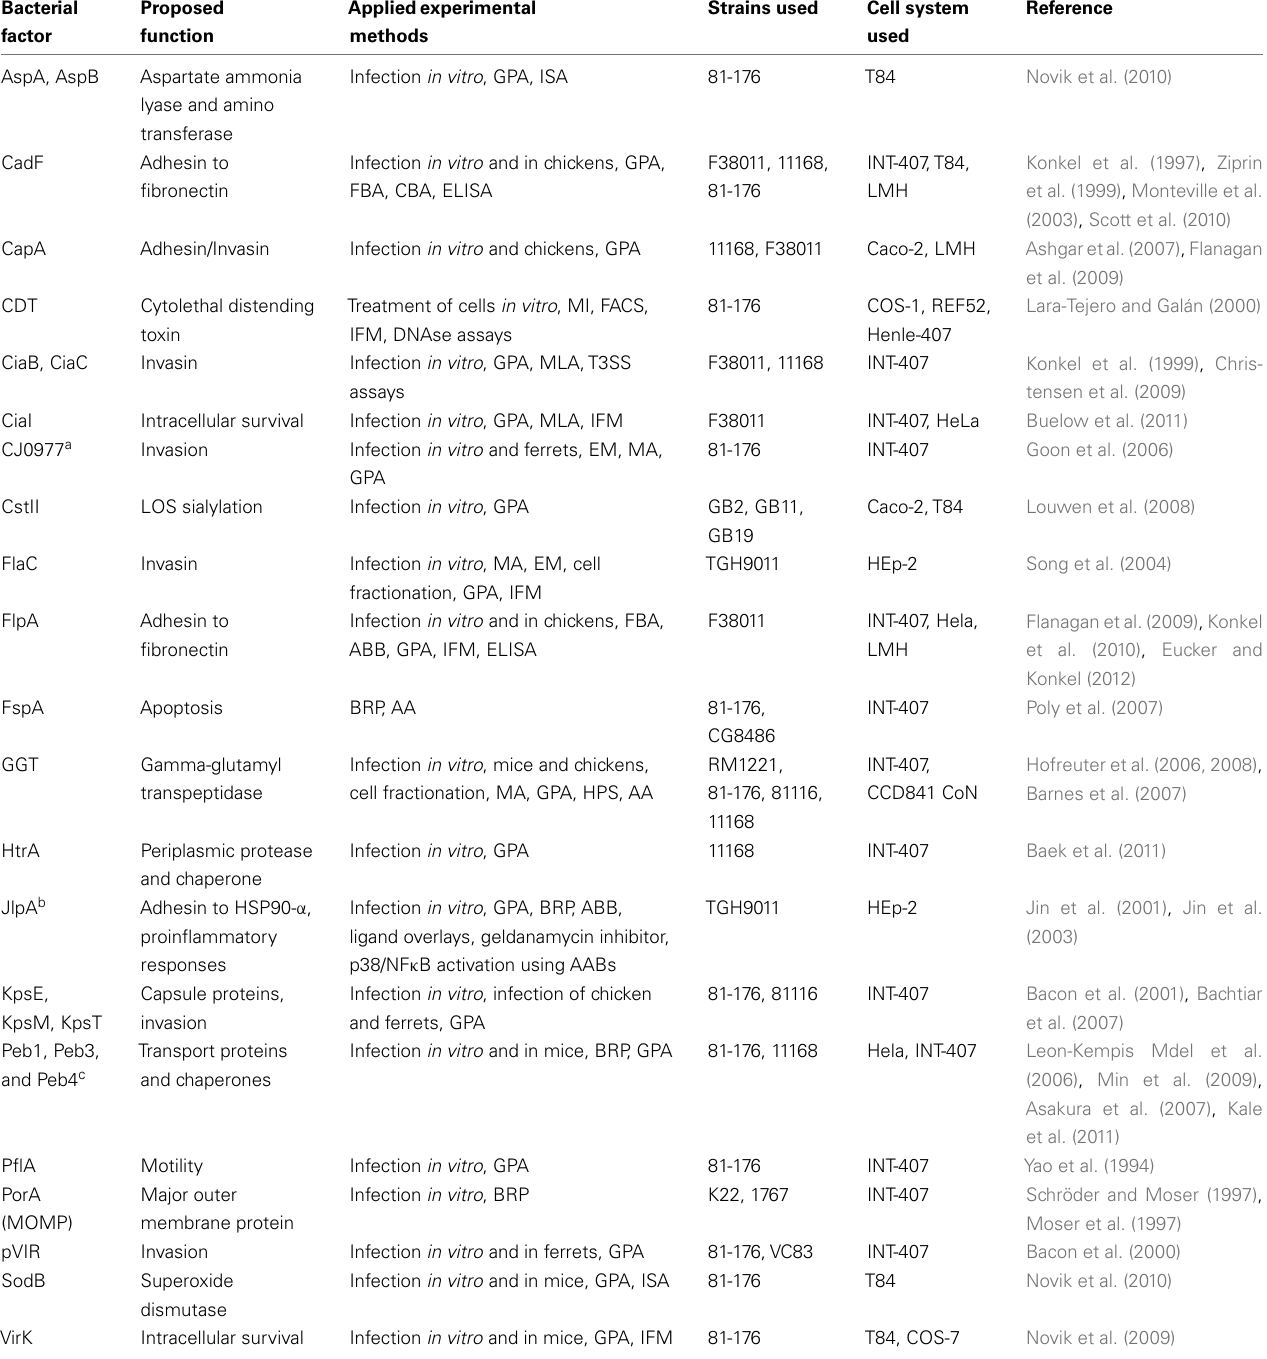
Table 1 | Bacterial factors and proposed roles in C. jejuni infection. Bacterial